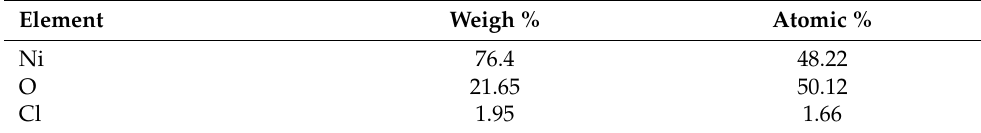
Figure 4. EDX spectrum of NiO sprayed thin films. Table 4. Chemical compositions in NiO